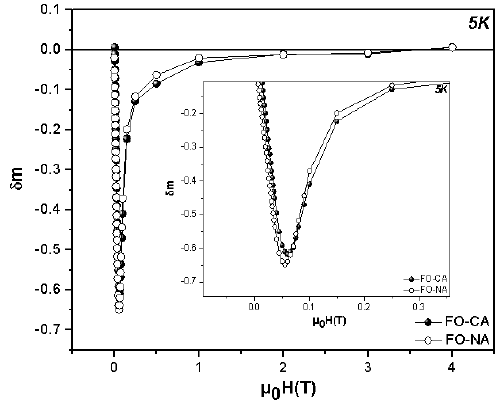
Figure 7. δ m plots for FO − CA and FO − NA samples .